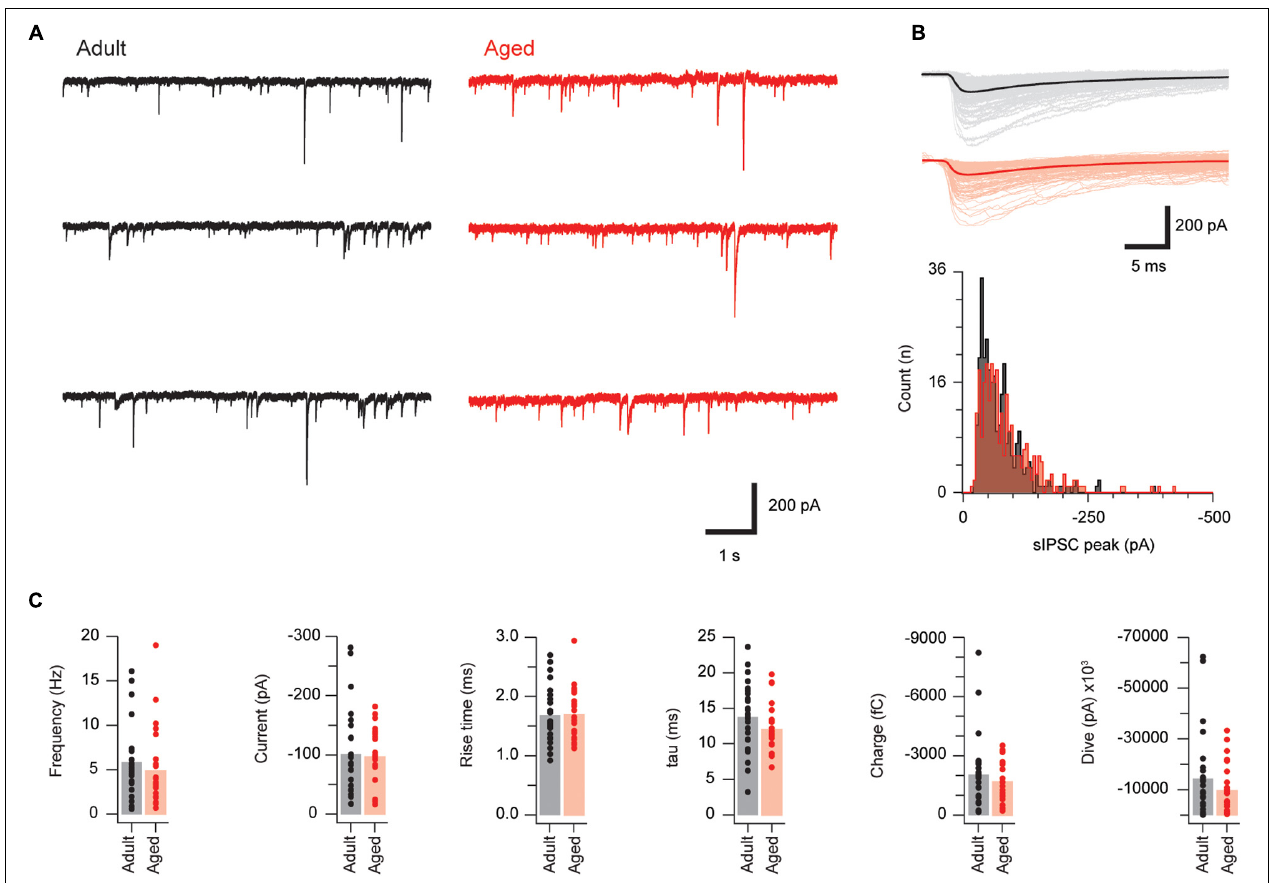
FIGURE 3 | Synaptic inhibition is similar in adult and aged PVINs. (A) Representative traces showing sIPSCs in adult (left, black) and aged (right, red) PVINs. (B) Upper overlaid sIPSC traces captured from records in (A) with averaged responses indicated by heavier traces. Lower plots show amplitude histograms highlighting similar amplitude distributions in adult and aged sIPSC recordings. (C) Plots showing group data for sIPSC properties. Note, the similarly in all sIPSC properties measured in adult and aged mice. Each data point represents the mean of at least 20